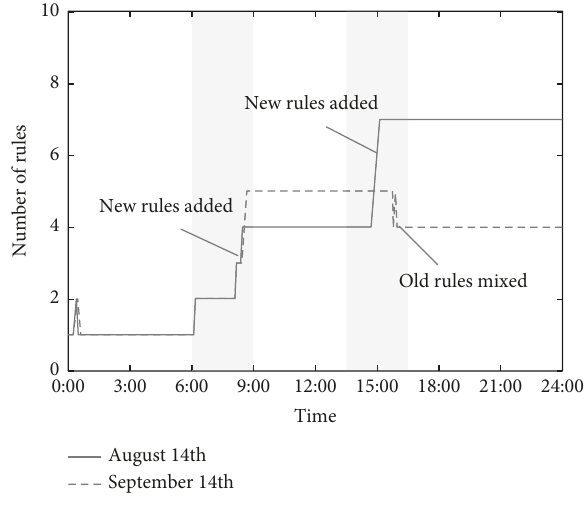
Figure 8: The changes of rules’ numbers.